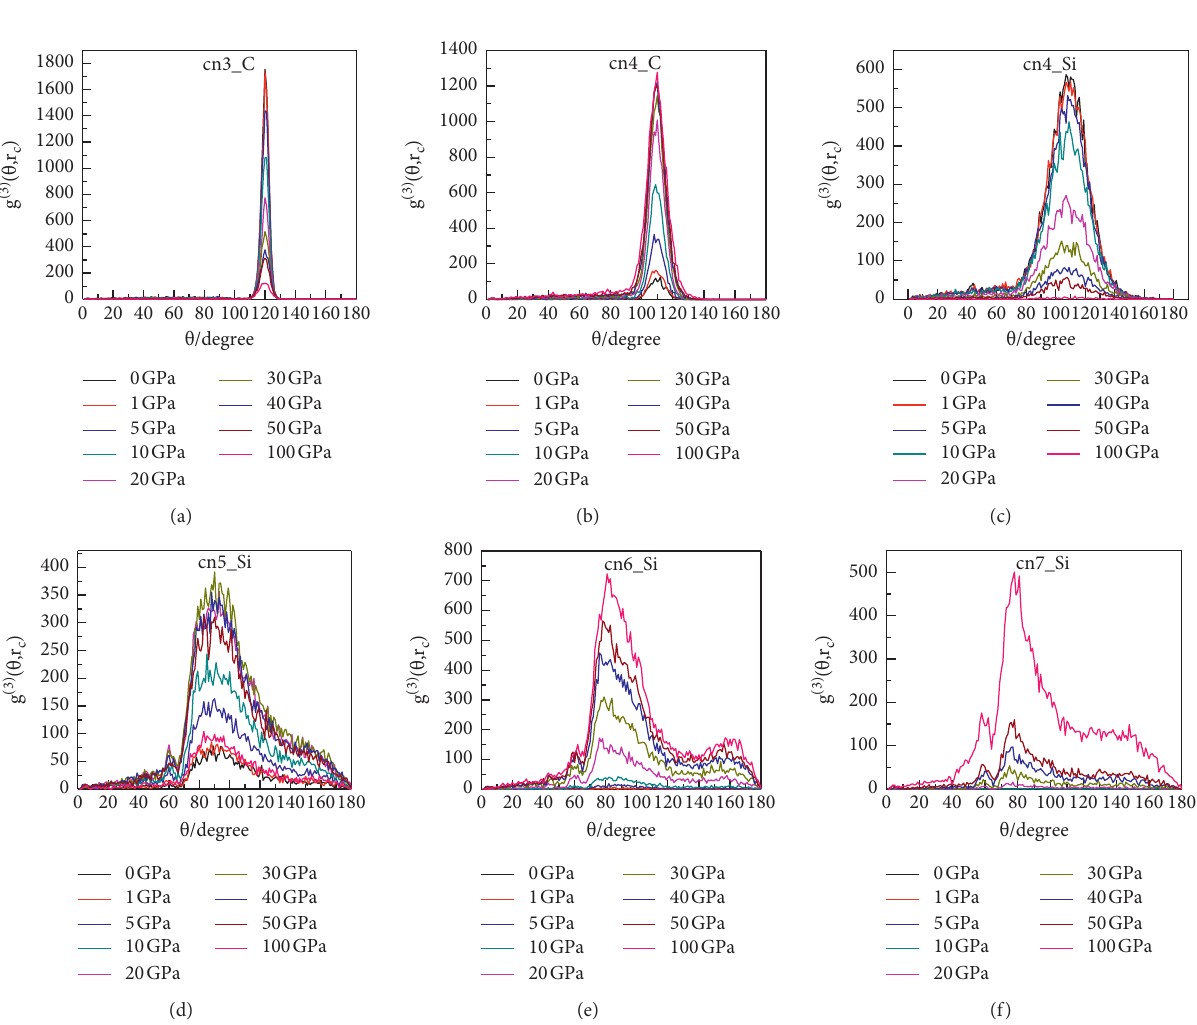
Figure 8: At 100K, the relationship between the number of bond angles centered on Si and C atoms with pressure.